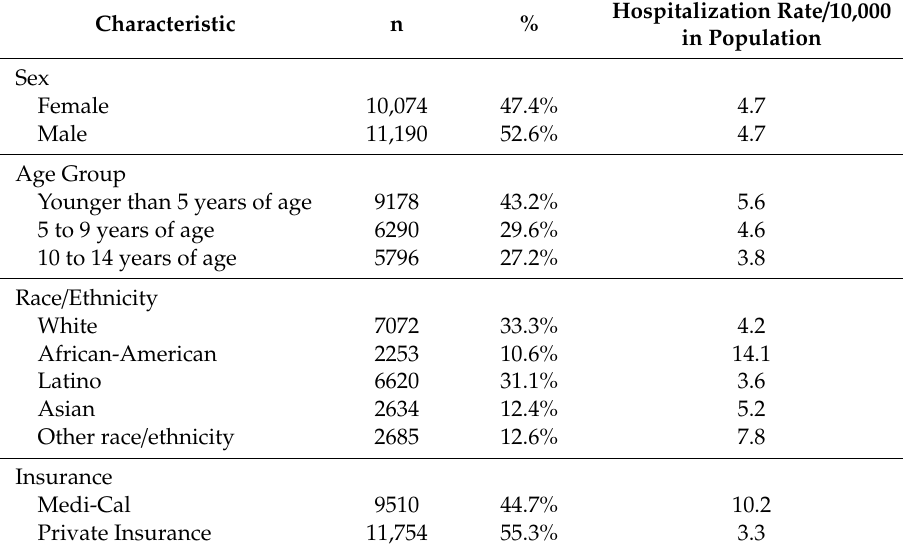
Table 1. Frequency, percentage, and rate of asthma-related hospitalization by characteristic (n = 21,264), 2010–2012, California.